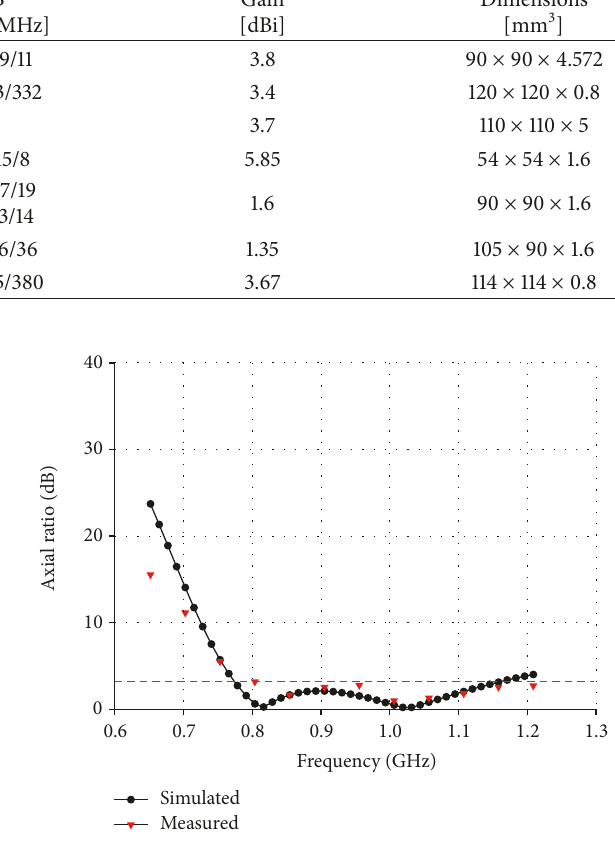
Figure 7: Simulated and measured AR bandwidth results of the manufactured